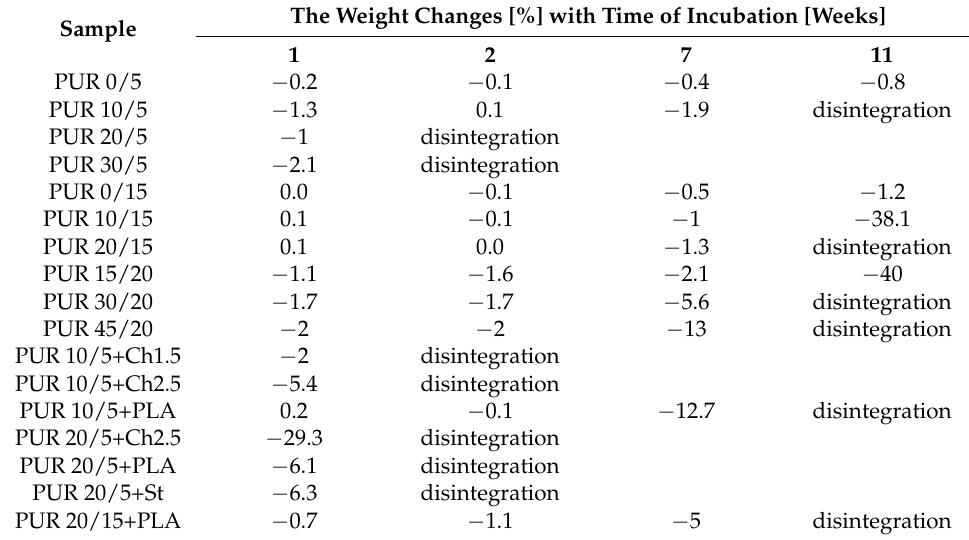
Table 7. The weight changes of samples after their incubation in oxidative